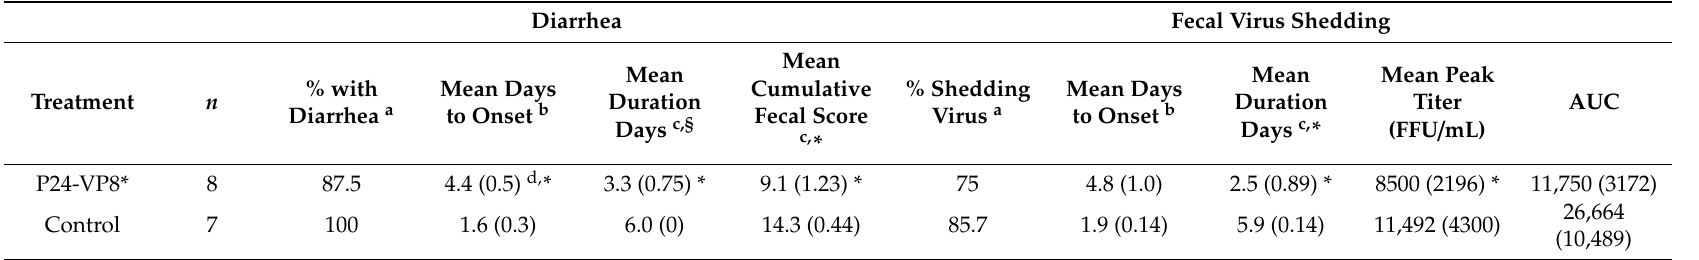
Table 2. Diarrhea and rotavirus fecal virus shedding in Gn pigs after the VirHRV challenge. Diarrhea Fecal Virus